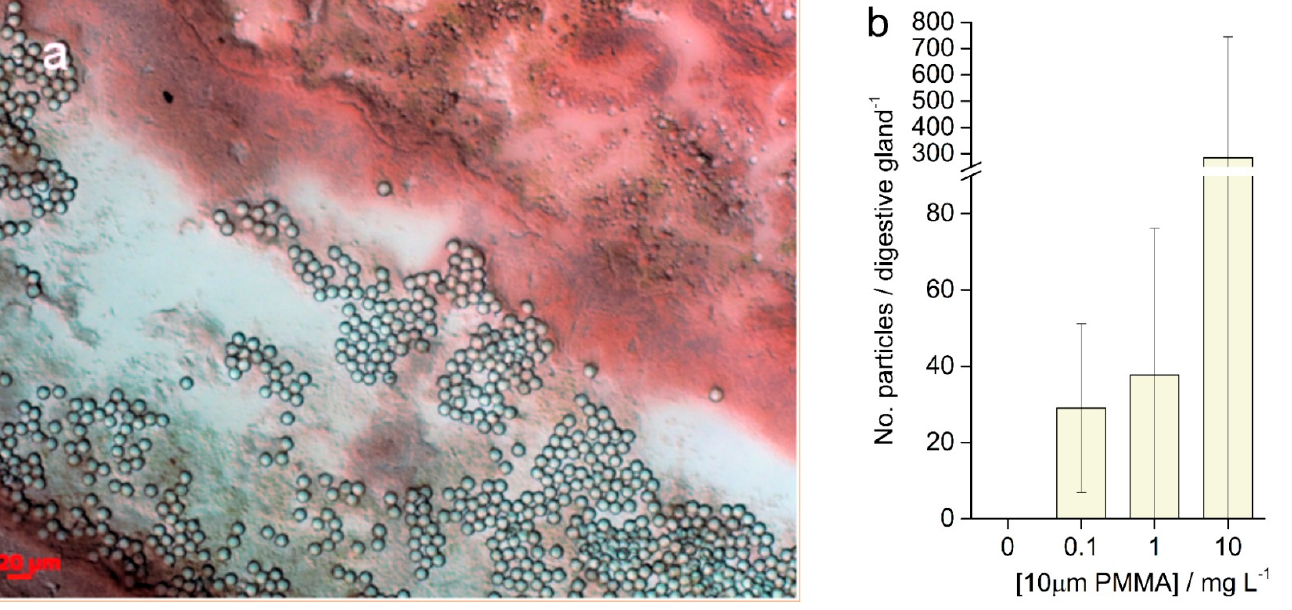
Figure 8. Micrographs of 10 μ m microparticles in a cryosection of the ( a ) hepatopancreas (scale bar 20 μ m) and ( c ) gill (arrow indicates microparticle; scale bar 10 μ m) for mussels exposed to 10 mg L − 1 (HIGH) PMMA, and particle counts (mean ± SD) in ( b ) hepatopancreas and ( d ) gill cryosections for mussels exposed to 0.1 mg L − 1 (LOW), 1.0 mg L − 1 (MID) and 10 mg L − 1 (HIGH) microparticles. 3.5. Enzymatic Activities The specific activities of a range of enzymes in the mussel gill and hepatopancreas tissue were determined after 72 h exposure of mussels to the 10 μ m and 50 μ m PMMA microplastics. Acetylcholinesterase activity in the gills was slightly suppressed for the smaller microparticles compared to the larger particles, although it was not statistically different from the control (Figure 9a). Catalase activity also showed values close to the control without any trends apparent (Figure 9b). Glutathione ‐ S ‐ transferase activity in the gill tissue was lower than the control for the highest concentration of 10 μ m